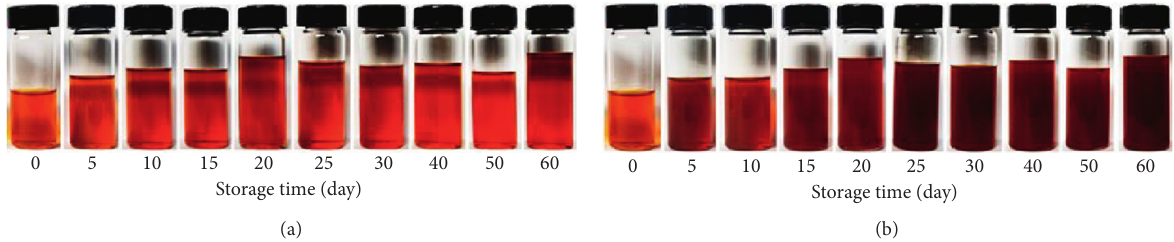
Figure 3: Colour of the SeNP/OCS solution stored at 4 ° C (a) and 27 ° C (b) for 0 to 60 days.